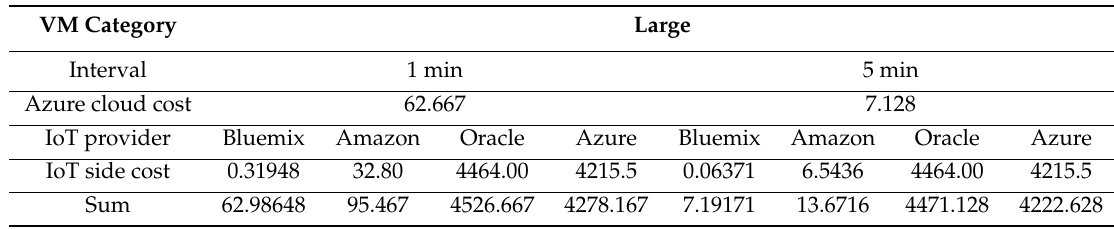
Table 5. IoT costs with a large VM category in scenario N o